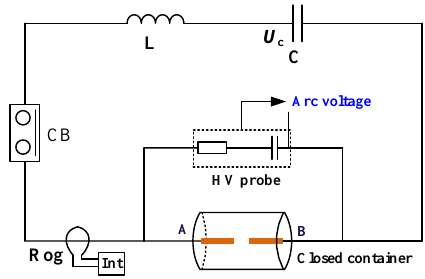
Figure 7. Schematic diagram of the current circuit.